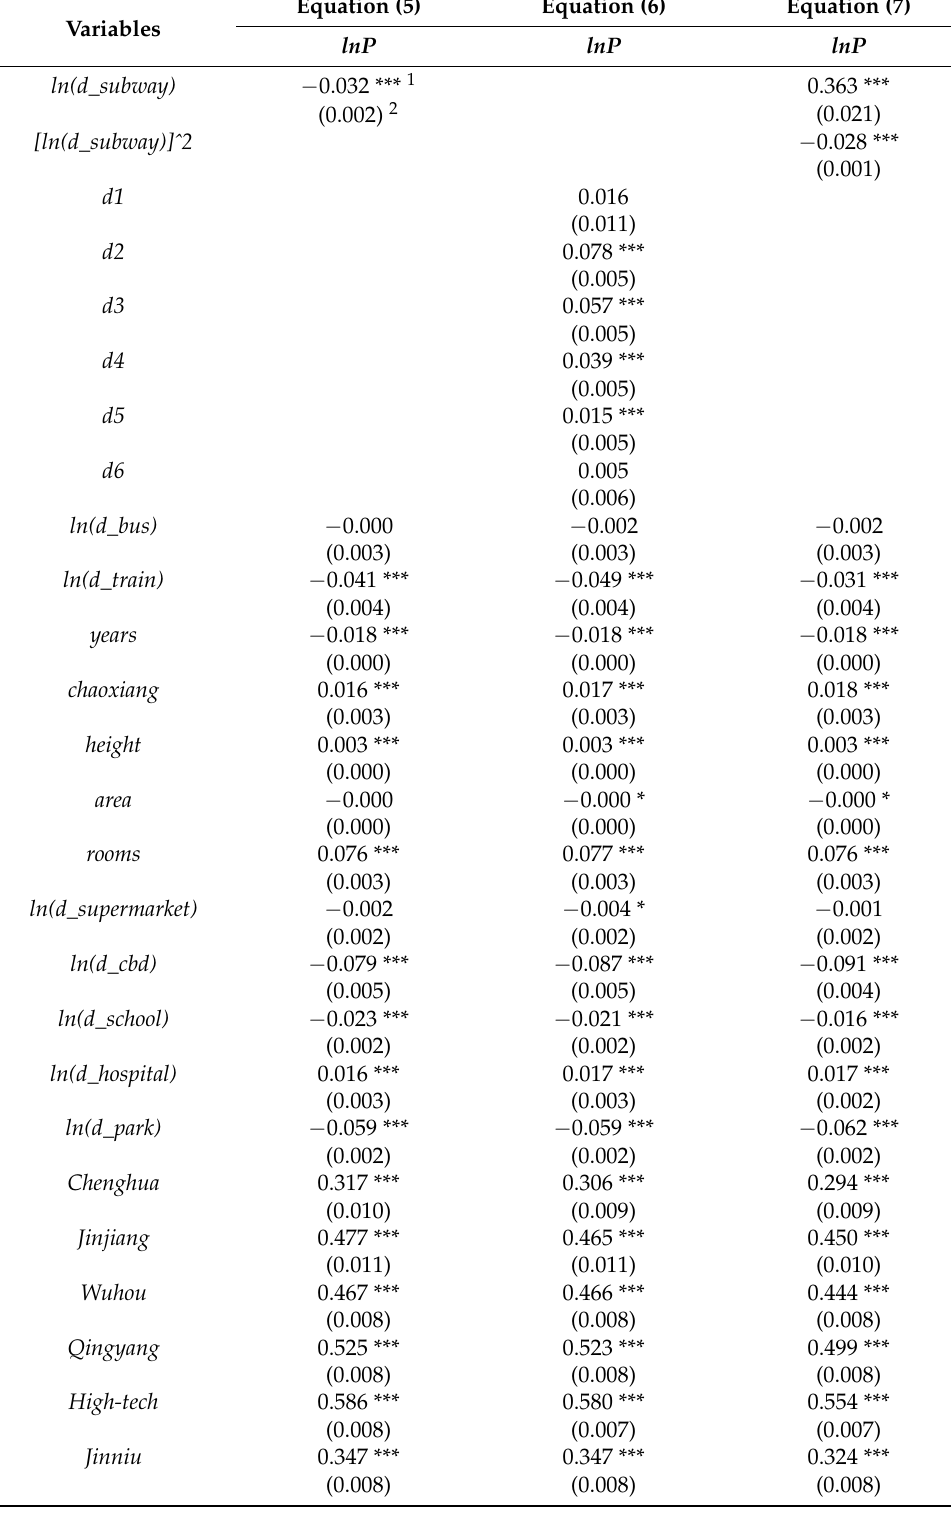
Table 3. Results of ordinary least squares